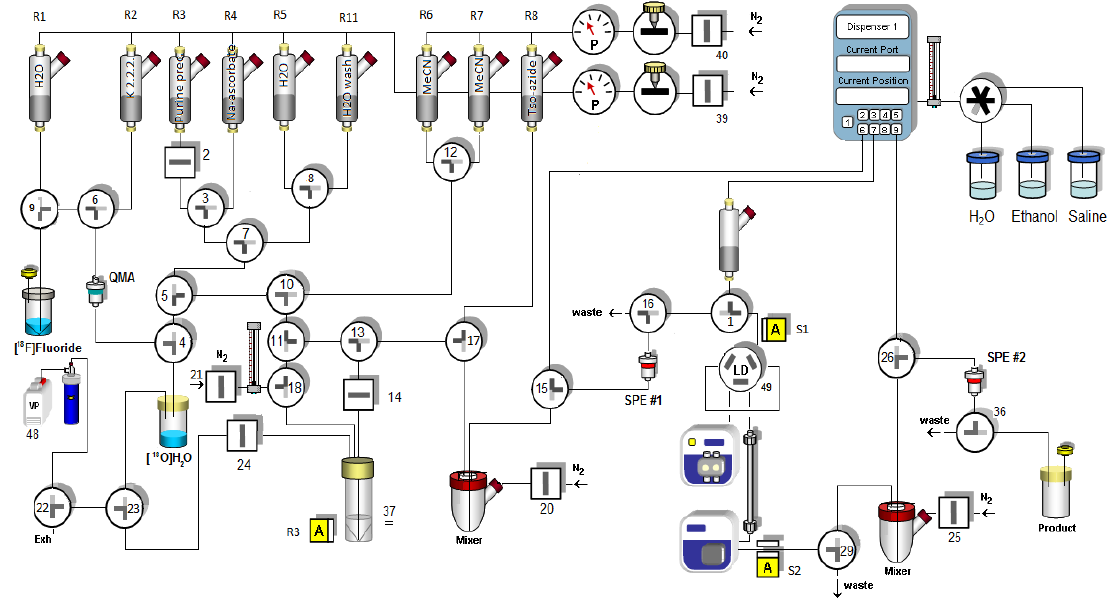
Figure 3. Schematic representation of the configuration of the HBIII synthesis